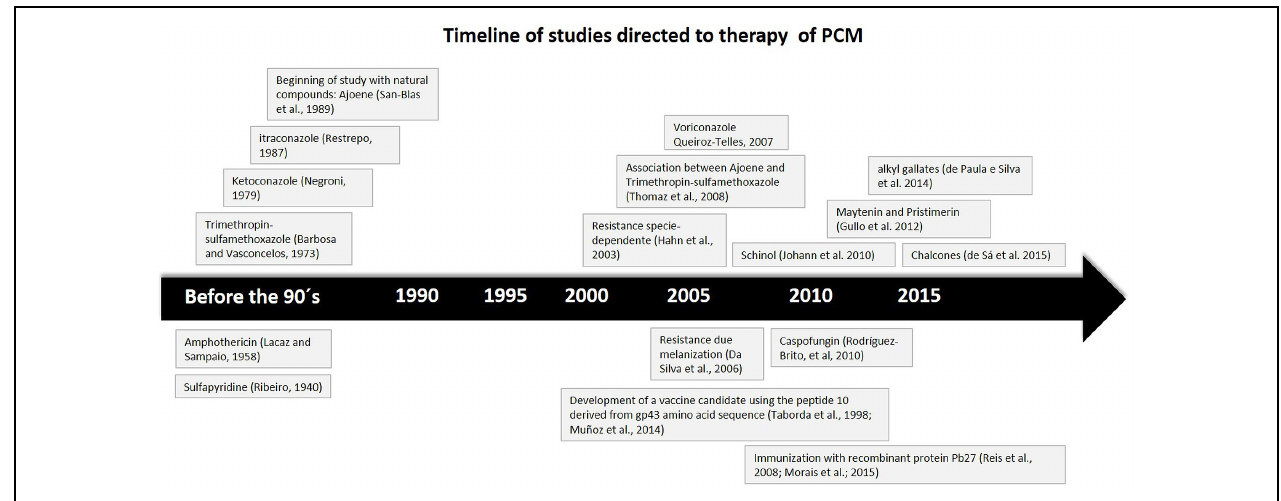
FIGURE 3 | Time line based on studies that brings development and new insights on treatment and active biomolecules against PCM.